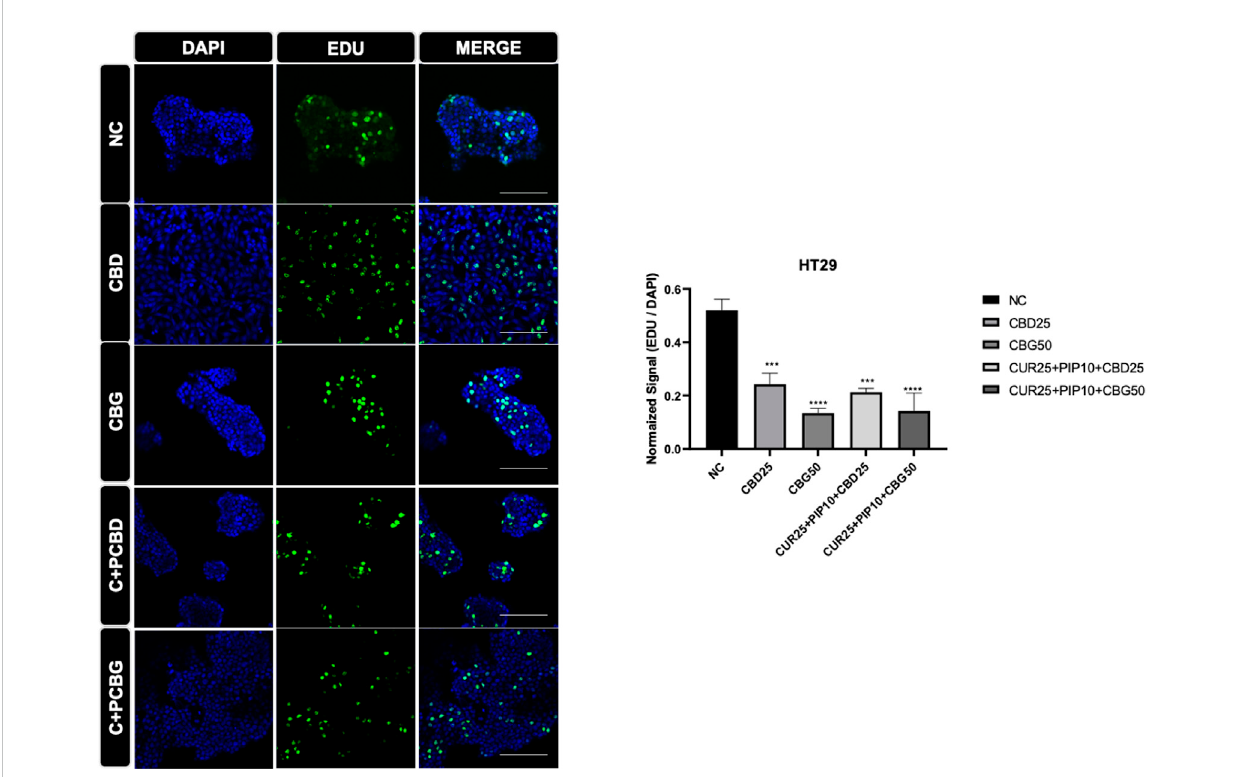
FIGURE 9 Representative results of the EDU assay are shown for HT29 cell line. Dividing cell were labelled with EDU (green). DAPI staining was in blue in the nucleus. Histogram graph was indicated normalized signaling rate of EDU